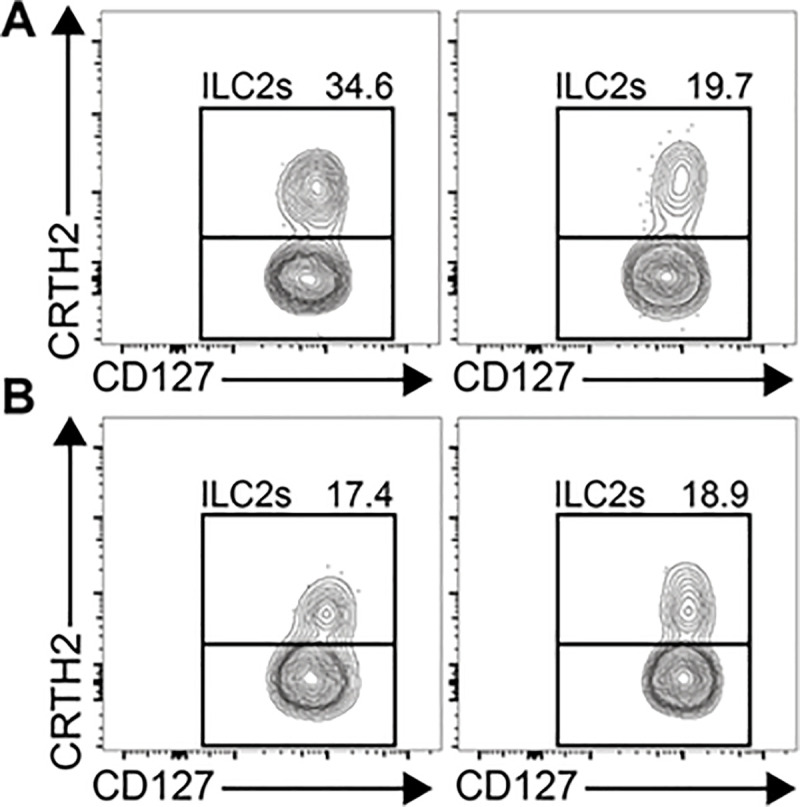
ILC2s decrease in blood but remain the same in adipose tissue.In the sitagliptin-treated participants, changes in the ILCs in peripheral blood mononuclear cell (PBMC) fractions often were not congruent with the change or lack of change in the same cell lines in abdominal adipose tissue (data not shown). Panel A exemplifies a decrease in ILC-2 in PBMCs from a participant before and after 28 days of treatment with sitagliptin, respectively. Panels B shows no difference in ILC-2 from adipose tissue in the same participant before and after treatment, respectively.